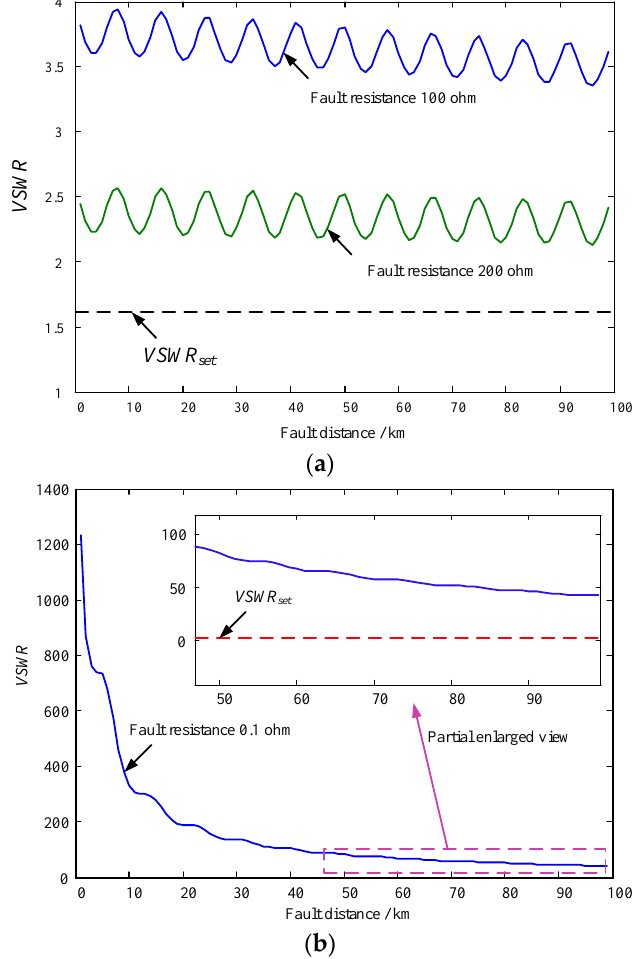
Figure 11. The VSWR for different fault position of double-line earth fault with mismatched terminal resistor. ( a ) the transition resistance are 100 Ω and 200 Ω, respectively; ( b ) the transition resistor. ( a ) the transition resistance are 100 Ω and 200 Ω , respectively; ( b ) the transition resistance is resistance is 0.1 Ω. 0.1 Ω